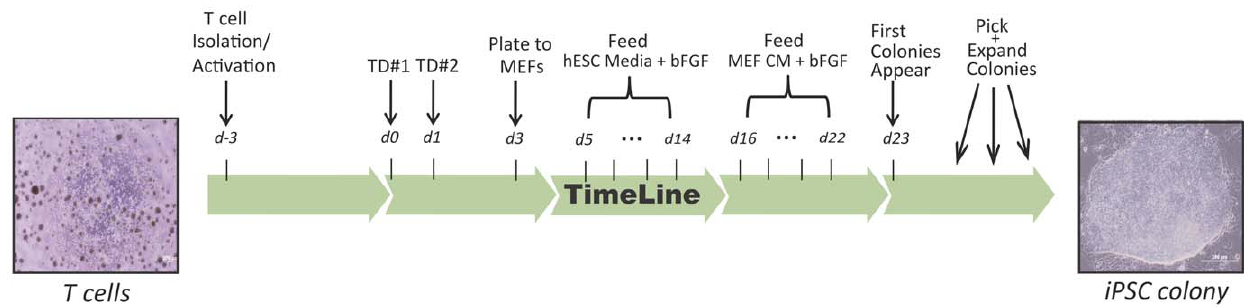
Figure 1. Overview of T-cell reprogramming process, beginning with activated T-cells and resulting in iPSC colonies with hESC-like morphology. T-cell and iPSC colony images were acquired on an Olympus IX71 microscope with 10 6 and 20 6 objectives, respectively.